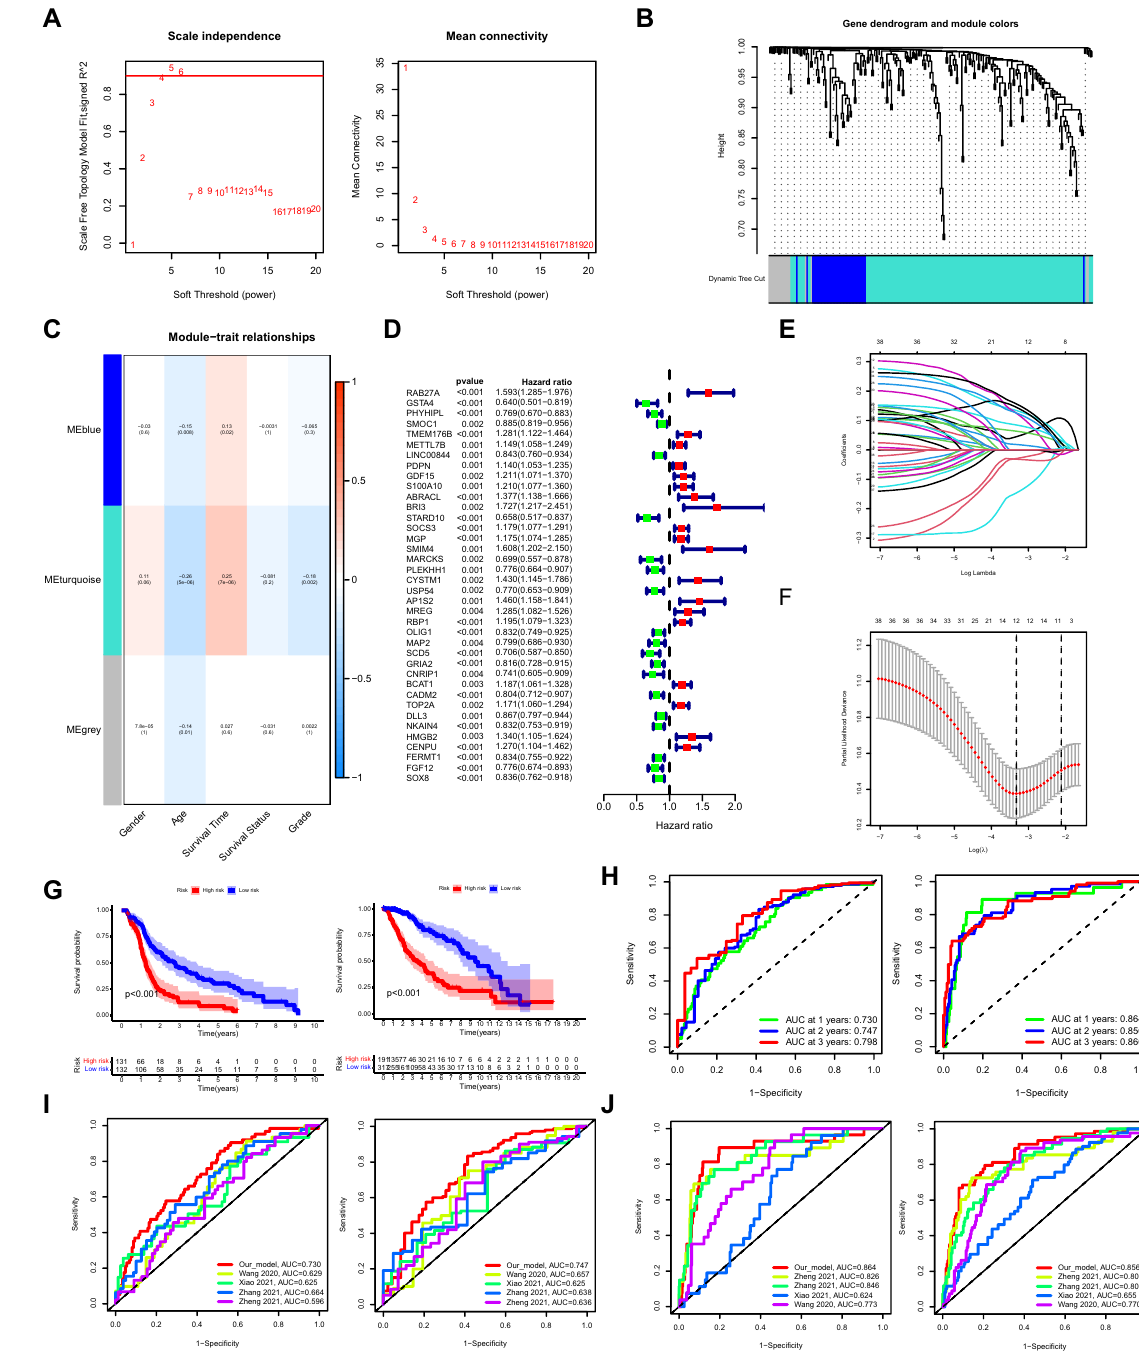
Figure 5. Construction of prognostic model based on DRGs. ( A , B ) Three modules were identified with the optimal soft threshold = 4 based on WGCNA. ( C ) The result of correlation analysis between modules and clinicopathological features. ( D ) Forest plot displaying the result of univariate cox analysis of DRGs. ( E ) The coefficient profile plot against the log(lambda) sequence in the LASSO model. ( F ) Optimal parameter (lambda) selection in the LASSO model. ( G ) Kaplan–Meier analysis between the low-risk group and the high-risk group in the training (left panel) and validation (right panel) cohorts, respectively. ( H ) The ROC curves for predicting 1-year, 2-year and 3-year overall survival in the training (left panel) and validation (right panel) cohorts, respectively. ( I ) The ROC curves showing the comparison between our prognostic model and other recently established models in the training cohort for predicting 1-year (left panel) and 2-year (right panel) overall survival, respectively. ( J ) Similar results in the validation cohort. DRGs: differentiation related genes, WGCNA: weighted correlation network analysis, LASSO: least absolute shrinkage and selection operator, ROC: receiver operating